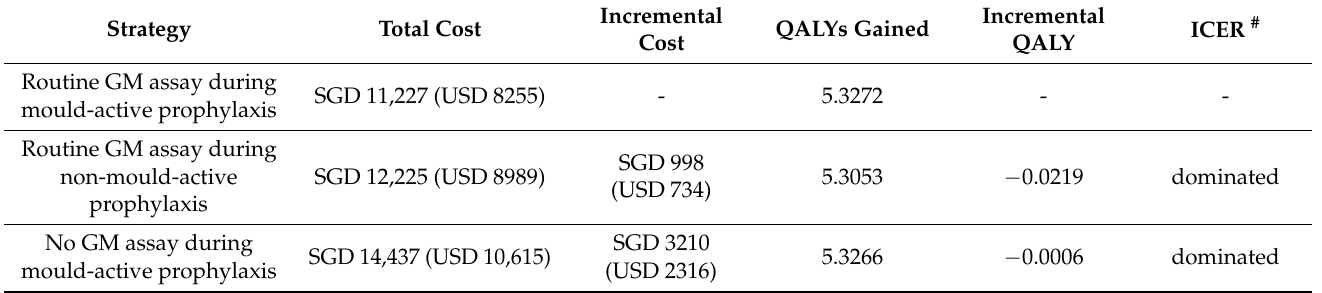
Table 2. Total cost, effectiveness, and incremental cost-effectiveness ratio of various prophylaxis-biomarker strategies in the 40-year-old cohort.